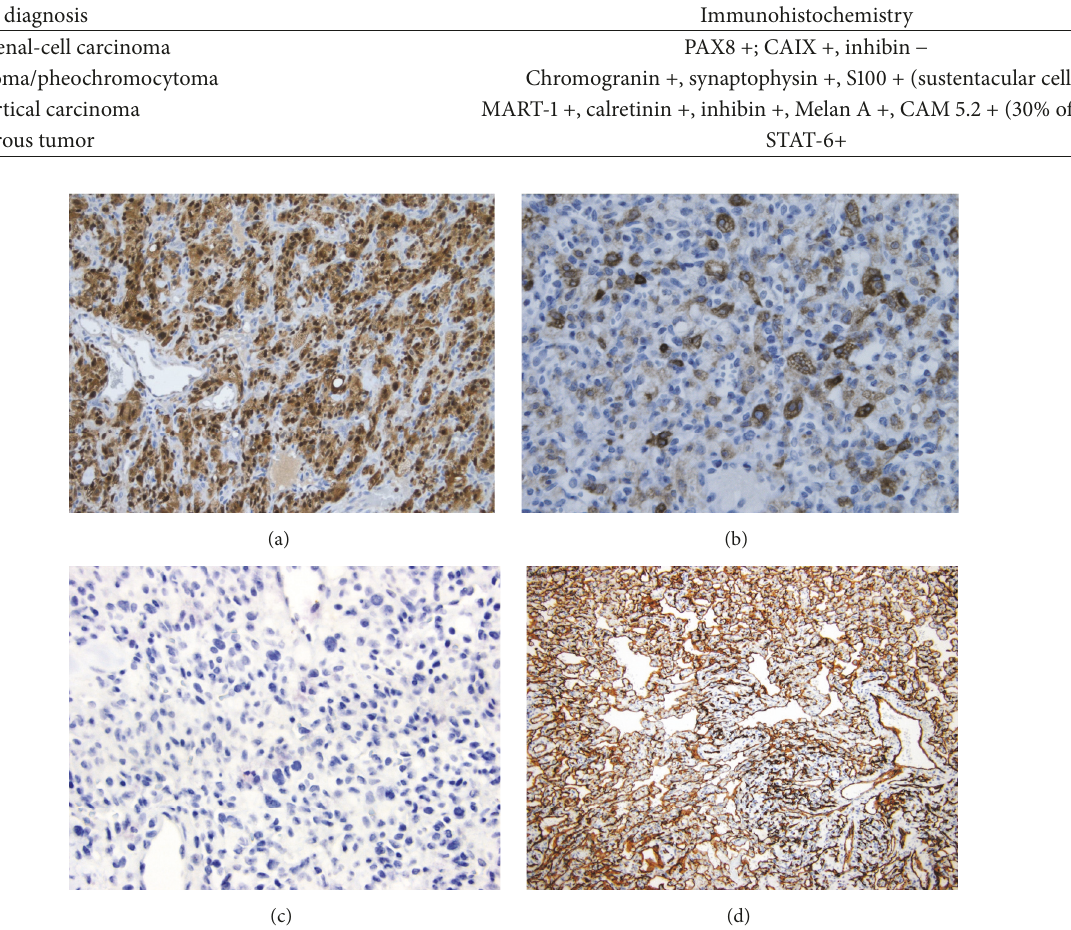
Figure 4: Immunohistochemical studies demonstrated diffuse S100 expression in the neoplastic cells ((a), S100 immunostain, 200x) and cytoplasmic expression of inhibin in the stromal cells ((b), inhibin immunostain, 400x). No expression of chromogranin was identified ((c), chromogranin immunostain, 400x). CD34 highlighted the prominent vascular network ((d), CD34 immunostain,